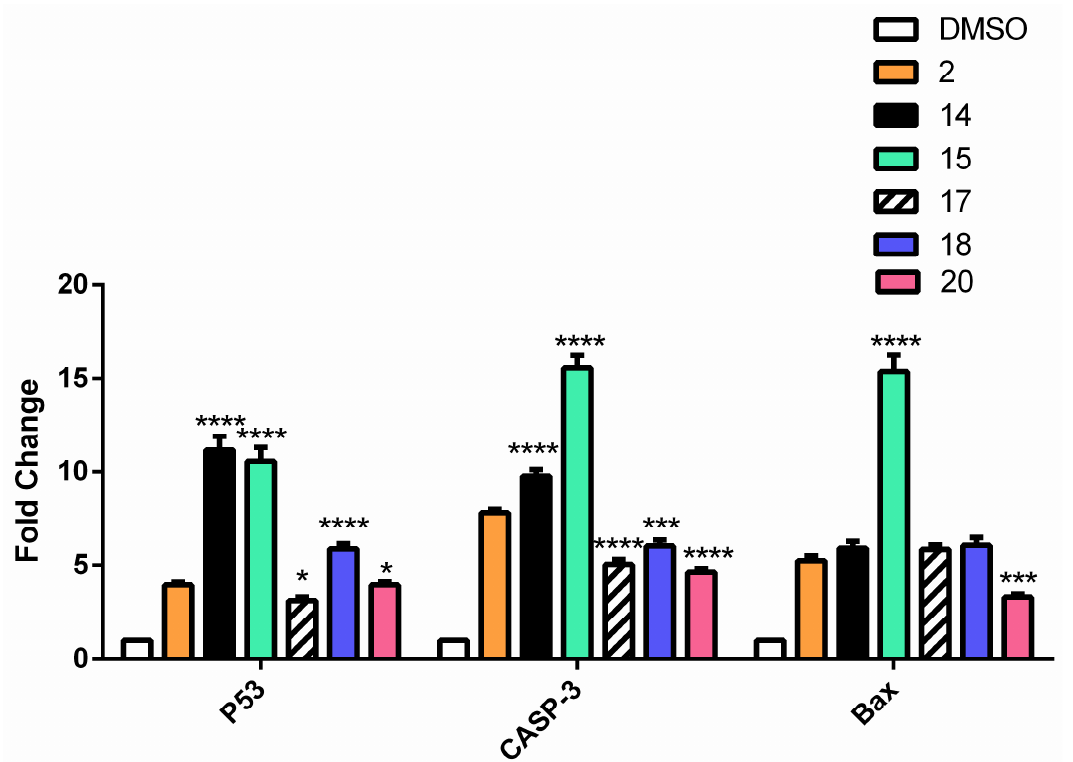
Figure 7. The effect of FA and its derivatives on the expression of P53, Caspase 3 and Bax genes by RT-qPCR. The results were represented as mean of fold changes ± SD. β -actin gene was used as a control gene. * Significant from FA at p < 0.05, *** Significant from FA at p < 0.001, **** Significant from FA at p < 0.0001.